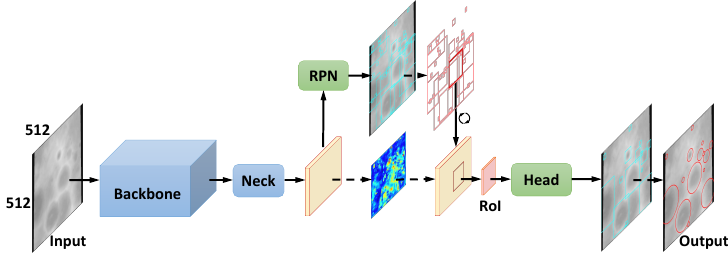
Figure 3. Architecture of the region-based detection network for lunar crater